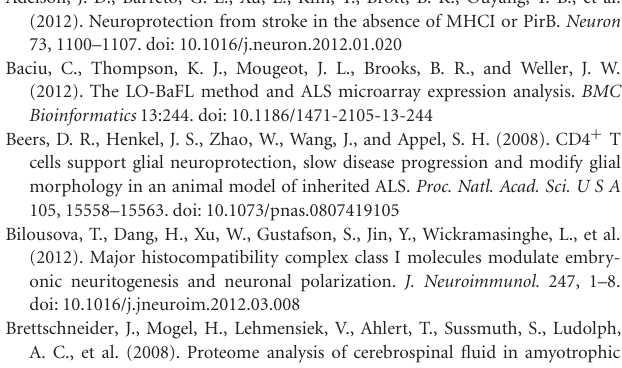
FIGURE 3 | Unaltered end stage pathology in β 2 m -deficient SOD1 G 93 A mice . Ventral horns of spinal cord sections of non-transgenic (ntg, n = 4; A and E ) and SOD1 G 93 A ( n = 4; B and F ) and β 2 m − / − SOD1 G 93 A ( n = 2; C and G ) SOD1 G 93 A mice. Nissl staining was used to visualize the (motor) neurons (A–C) . The number